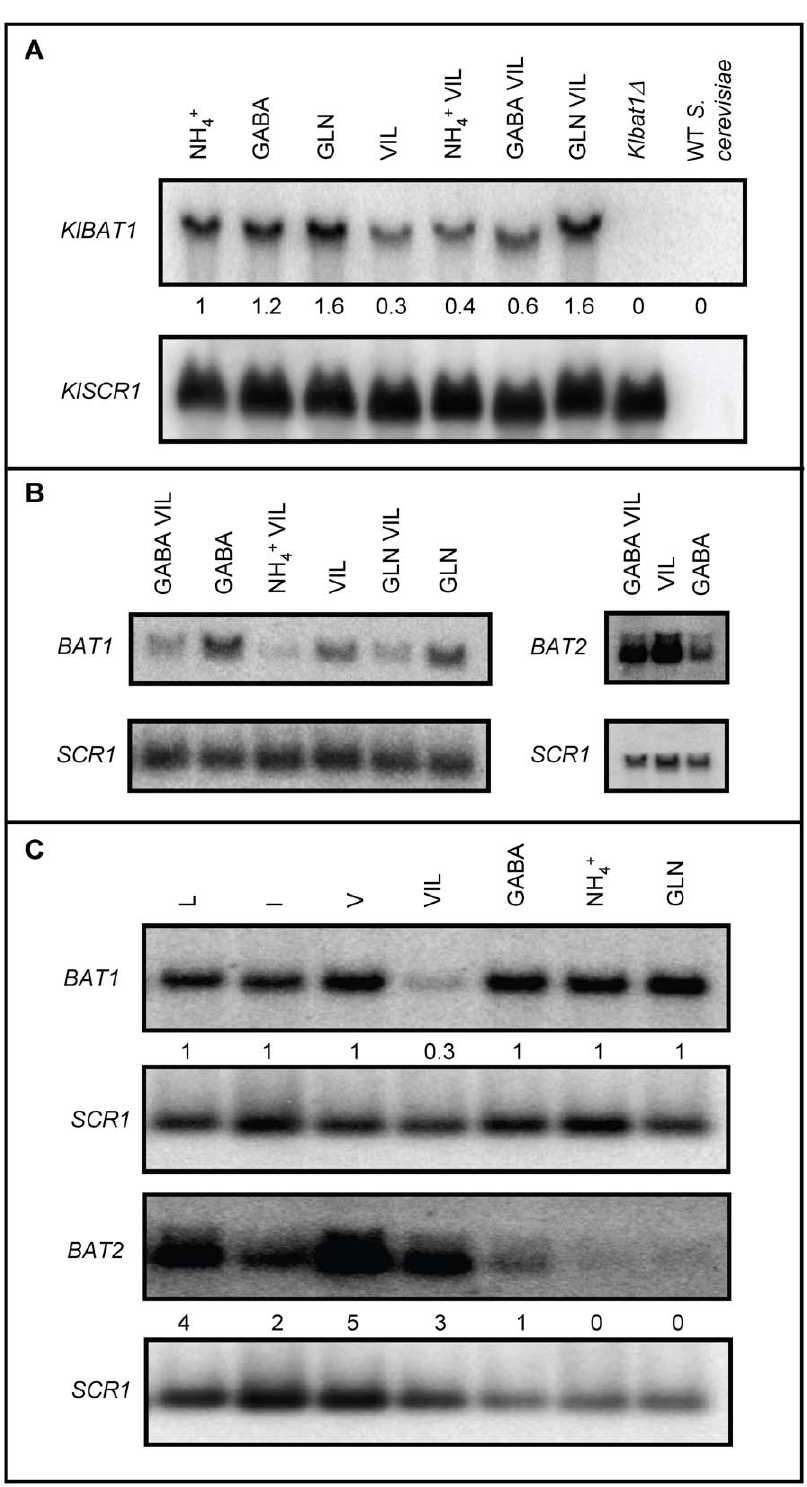
Figure 3. SaccharomycescerevisiaeBAT1 and KlBAT1 expression is repressed by VIL. Northern analysis was carried out on total RNA obtained from K. lactis 155 (wild type) and CLA34 ( Klbat1 D ) strains (A), and S. cerevisiae strain CLA1-2 (wild type B, C). Strains were grown on 2% glucose with either valine (V) (150 mg/l), leucine (L) (100 mg/l), isoleucine (I) (30 mg/l), c -aminobutiric acid (GABA 7 mM ), c -aminobutiric acid + VIL (GABA VIL),VIL (valine + isoleucine + leucine), NH 4 (40 mM NH 4 SO 2 ), NH 4 VIL (40mM NH 4 SO 2 + VIL), glutamine (GLN 7mM), glutamine + VIL (GLN VIL), as nitrogen sources. Filters were sequentially probed with the BAT1 , BAT2 , KlBAT1 - specific PCR products described in experimental procedures and a Bam H1- Hind III 1500 bp ACT1 DNA or an SCR 400bp PCR fragment as loading controls. Numbers indicate relative expression as compared to WT grown on ammonium-glucose. Four biological replicates were carried out, representative results are shown.